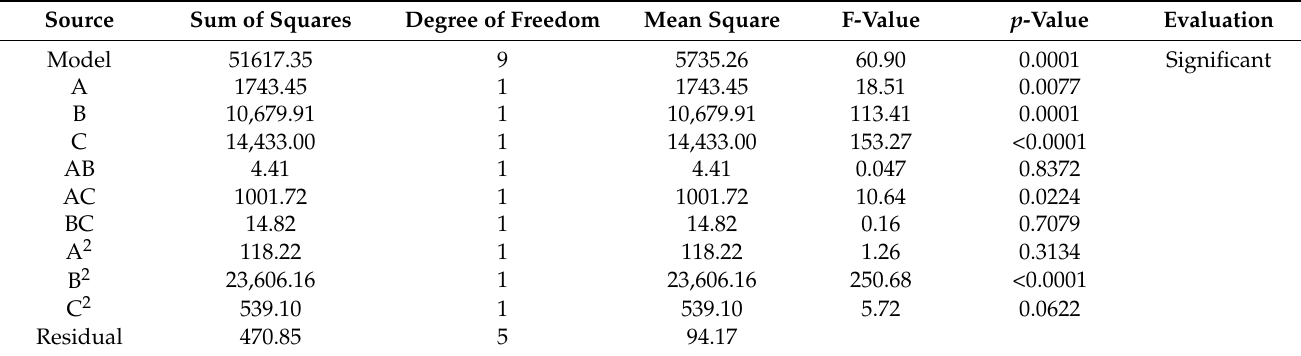
Table 4. Variance analysis of the quadratic polynomial model for size 1 .